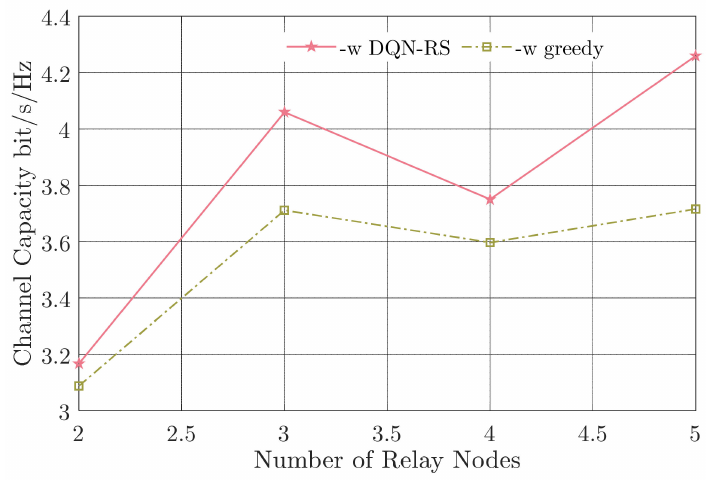
Figure 7. Channel capacity versus the number of relay